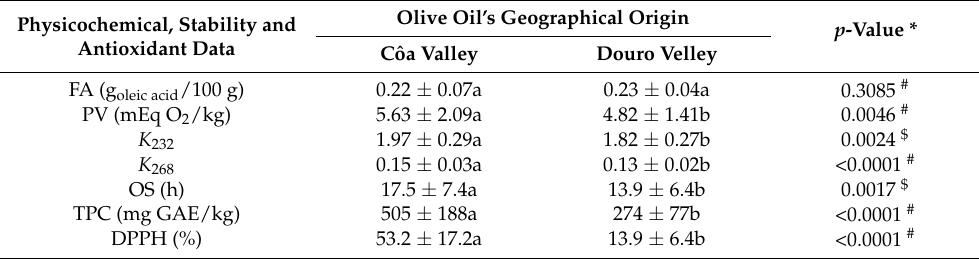
Table 1. Mean value ( ± standard deviation) of free acidity (FA), peroxide value (PV), extinction coefficients ( K 232 and K 268 ), oxidative stability (OS), total phenols content (TPC), and antioxidant activity (DPPH) of olive oils from C ô a (36 independent oils) and Douro regions (31 independent oils). Physicochemical, Stability and Antioxidant Data